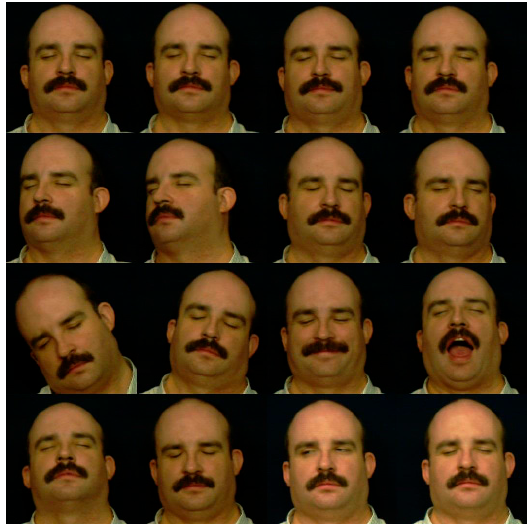
Figure 18. Example from the FRAV3D image database.